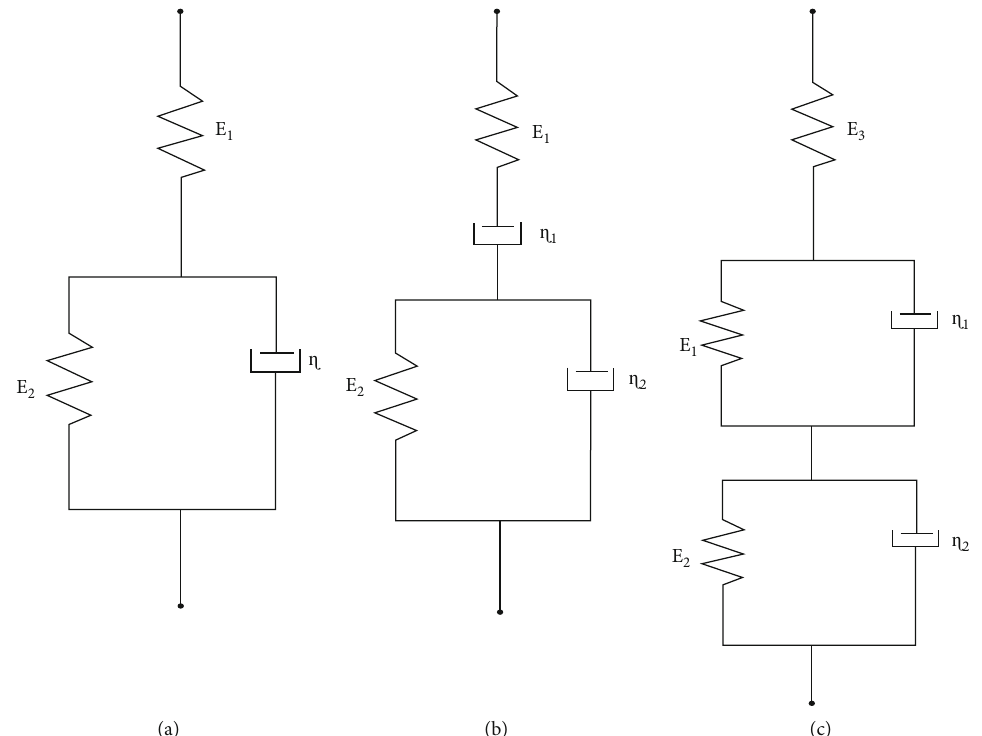
Figure 7: Viscoelastic models constructed from spring and dashpot elements to account for the viscoelastic behavior of quartz and clay minerals: (a) three-element Voigt model, (b) Burger ’ s model, and (c) two-dashpot Kelvin